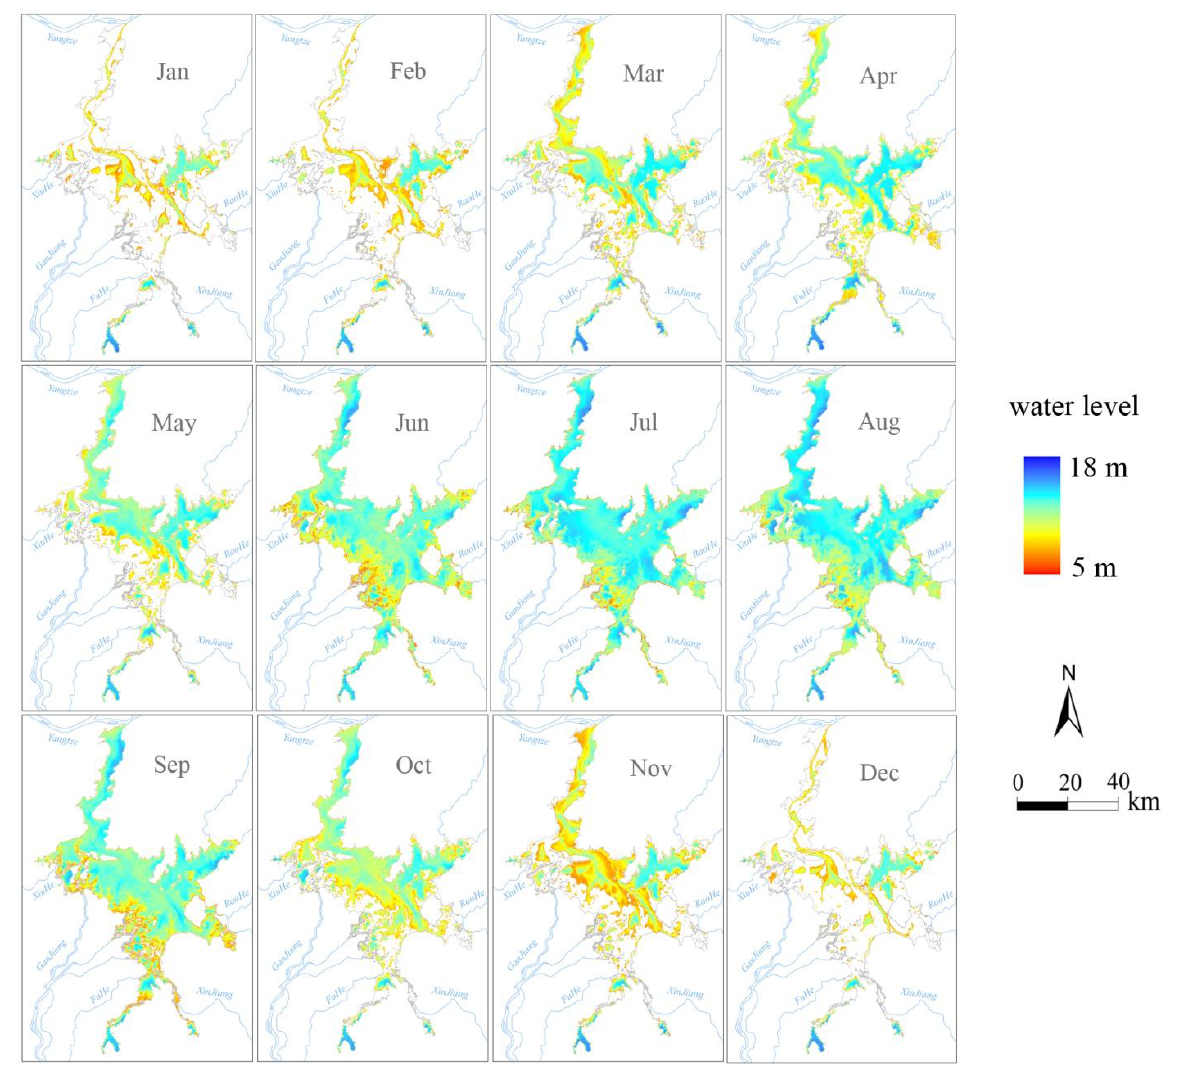
Figure 5. Mean seasonal distribution and variation of water levels during each climatological month between 2000 and 2012. The cells with the inundation frequency of <50% in each calendar month were excluded. Table 1. Mean value and standard deviation of water levels (unit: m) during each month between 2000 and 2012; these values reveal the inter-seasonal variability of water level. Month Jan Feb Mar Apr May Jun Jul Aug Sep Oct Dec